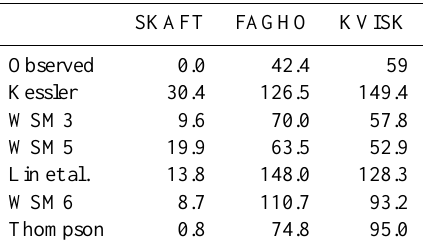
Table 3. Observed and simulated accumulated precipitation [mm], between 15 September, 18:00UTC and 16 September, 09:00UTC, at stations SKAFT, FAGHO and KVISK using various micro- physics schemes in combination with the MYJ PBL scheme in